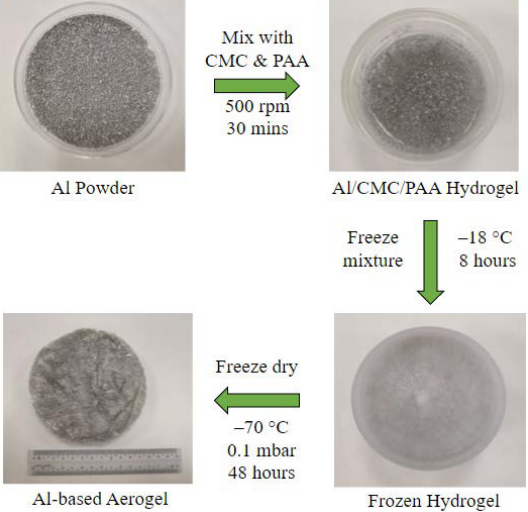
Figure 1. Fabrication procedure of aluminum - based aerogel.